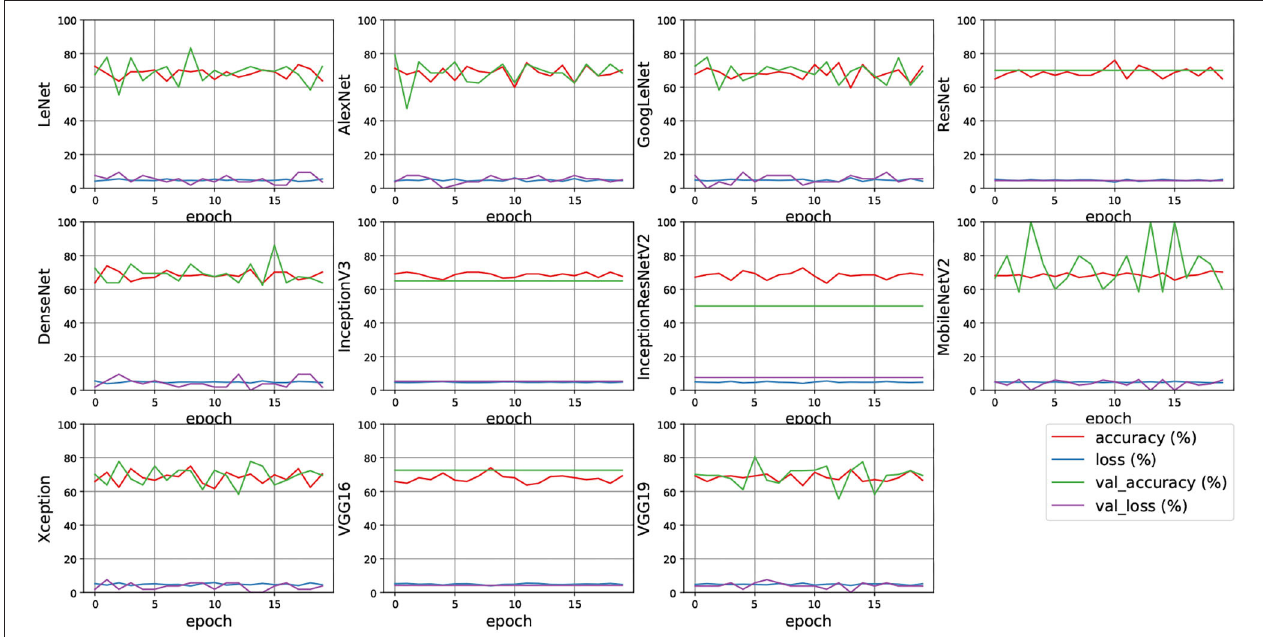
FIGURE 12 | Experimental results of deep learning